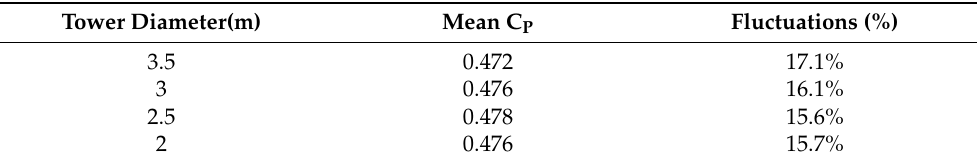
Table 1. Fluctuation in the Coefficient of performance for different tower diameter.